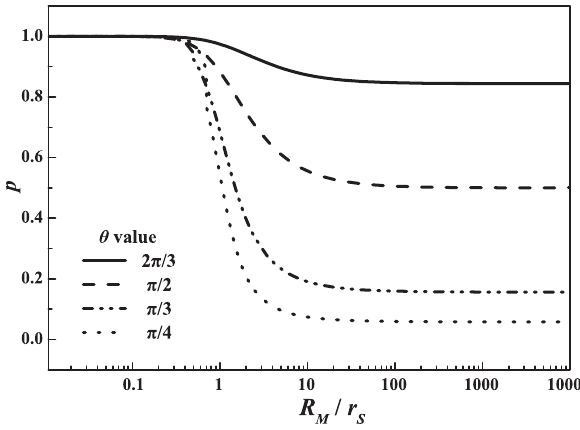
Fig. 4: Variations of factor p describing with the ratio of inclusion radius R M and FeSn 2 radius r S at different